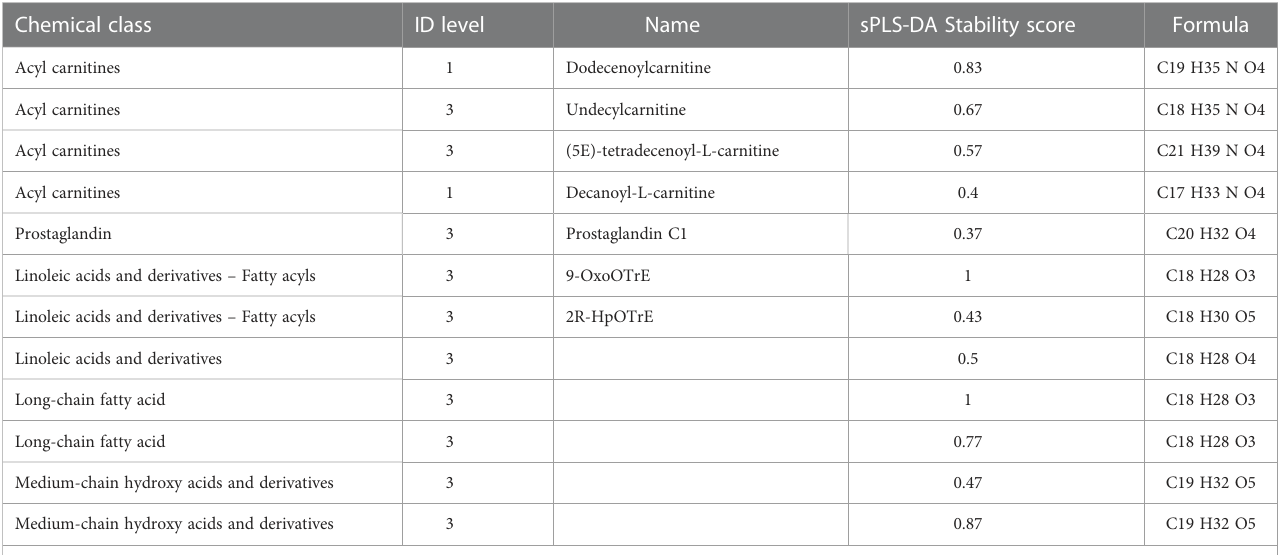
TABLE 2 Annotated metabolites (n=12) which contributed to the fi rst component in the sPLS-DA